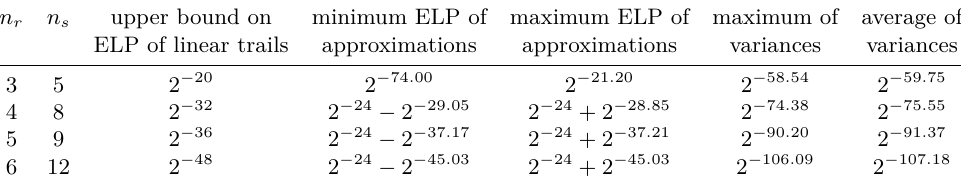
Table 3: ELP of single-tweak linear trails, highest and lowest ELP found for the single- tweak linear approximations and variances of ELP for 3 to 6 core rounds. n r and n s denotes the number of core rounds and the minimum number of active S-boxes in the linear trails. The variance , is the variance for ELP of all linear approximations with the same output